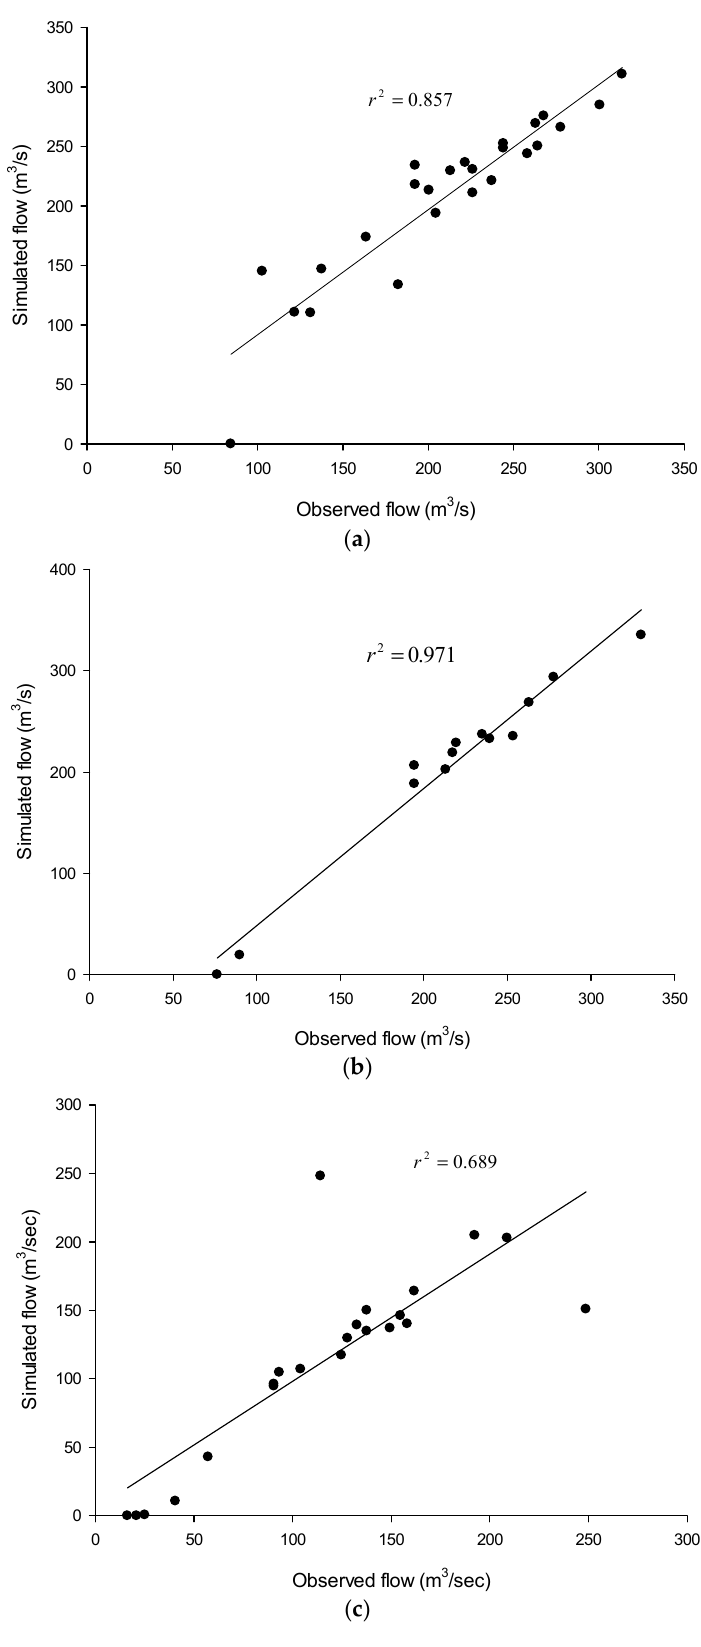
Figure 3. Correlation between observed and simulated flow during calibration ( a ) Event 1, ( b ) Event 4, and ( c ) Event 6.